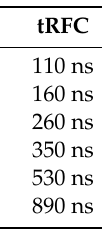
Table 1. Refresh cycle time among di ff erent